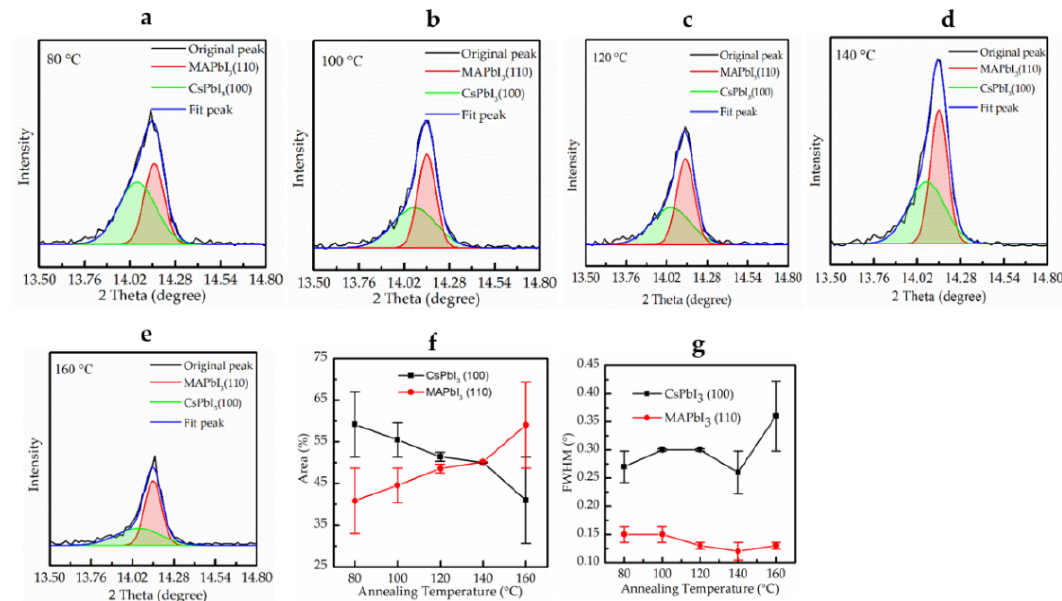
Figure 5. ( a – e ) XRD fitting patterns. ( f , g ) Area and FWHM of CsPbI 3 -QDs doped perovskite thin films at different annealing temperatures.